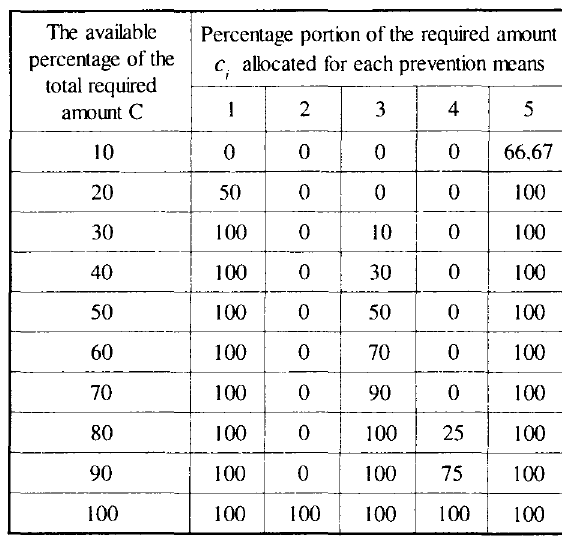
Table 1. Optimal allocation of funds intended for